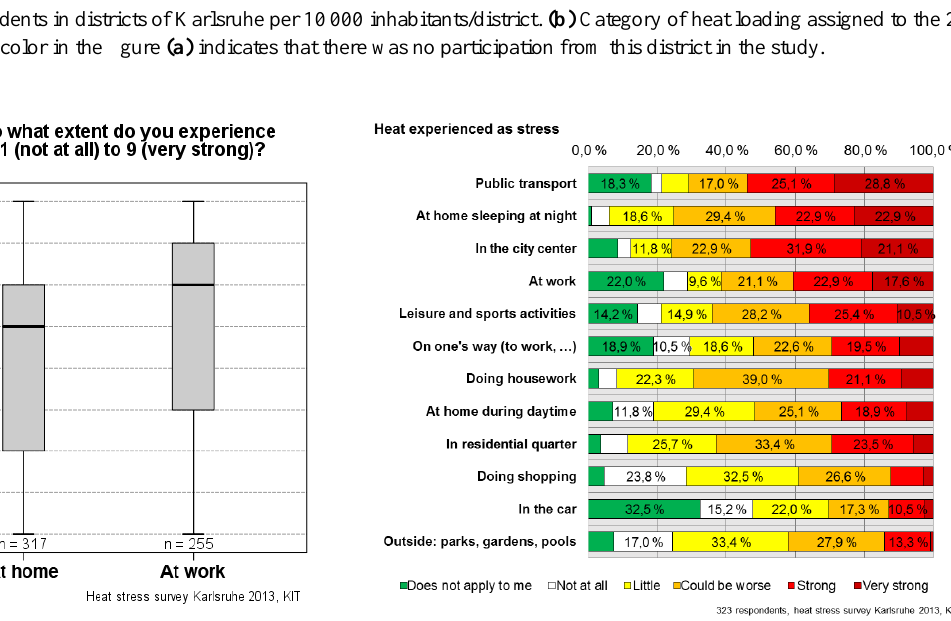
Figure 4. Subjective heat stress experienced by respondents in typ- ical daily activities. Exact numbers for percentages below 10% are not indicated in the